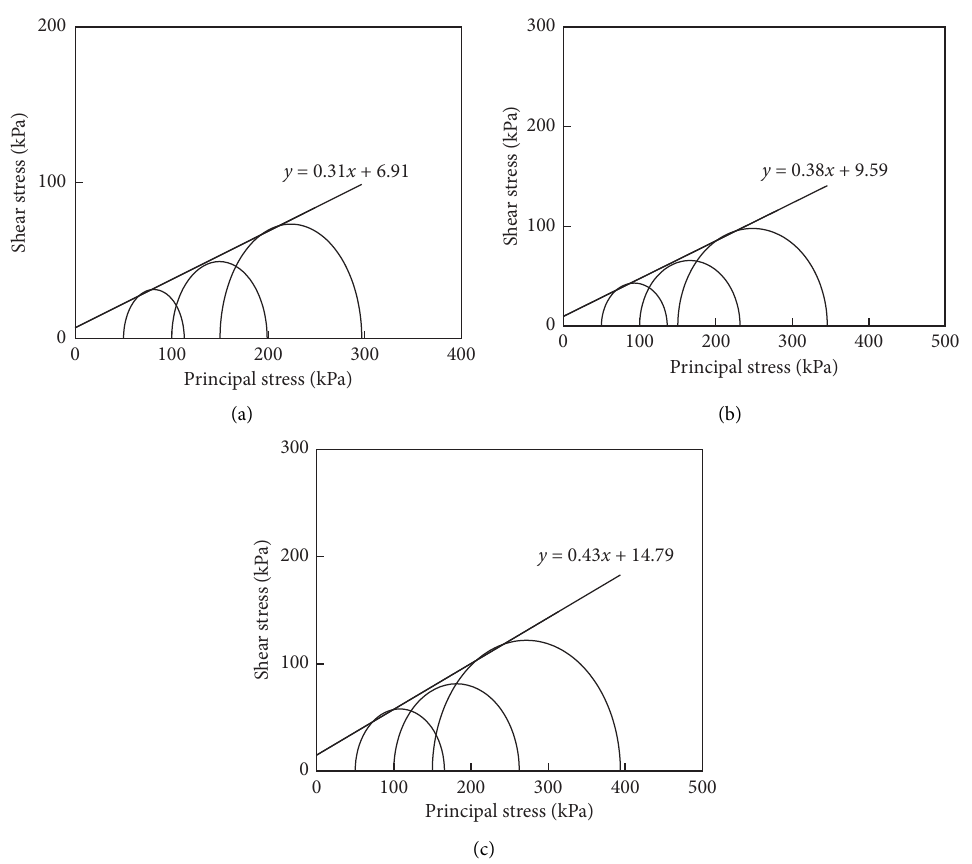
Figure 6: Strength envelope of samples with different degrees of compaction: (a) degree of compaction is 90%; (b) degree of compaction is 93%; (c) degree of compaction is 96%.